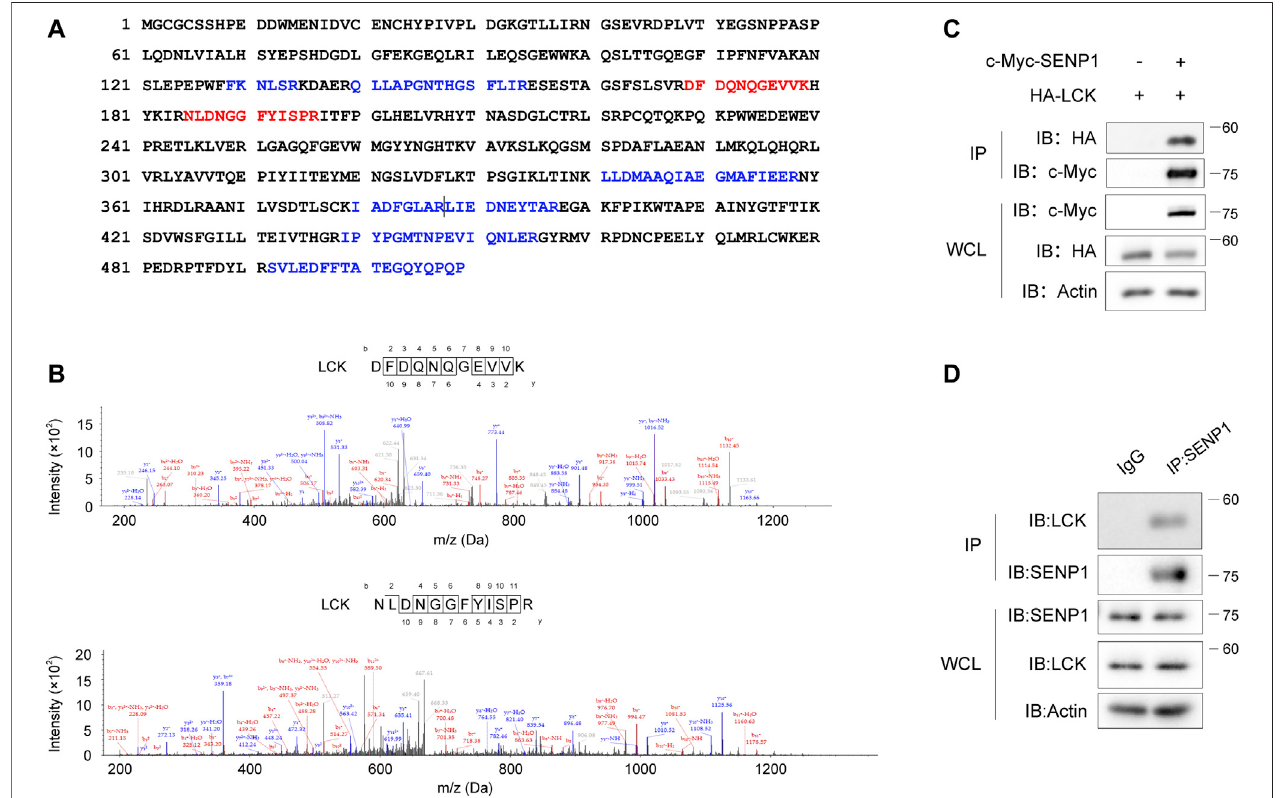
FIGURE 1 | Lck associates with SENP1. (A) Mapping of nine Lck peptides (highlighted in blue or red) on Lck full-length protein sequence. The nine Lck peptides were identi fi ed by mass spectrometry analysis of SENP1-immunoprecipitated complex from Jurkat E6.1 T cells (two consecutive peptides were separated by a vertical line). Identi fi ed Lck peptides with higher frequencies were marked red. (B) Fragmentation spectrum of the two Lck peptides with higher frequencies in (A) . m / z , mass/ charge ratio. (C) Coimmunoprecipitation of exogenously expressed c-Myc-SENP1 and HA-Lck (top) and immunoblots of whole-cell lysates (WCL, bottom) of HEK293Ttransfectants.IP,immunoprecipitation. (D) CoimmunoprecipitationofendogenousSENP1andLckinJurkatE6.1Tcells(top)andimmunoblotsofJurkatE6.1 T cell lysates (WCL,